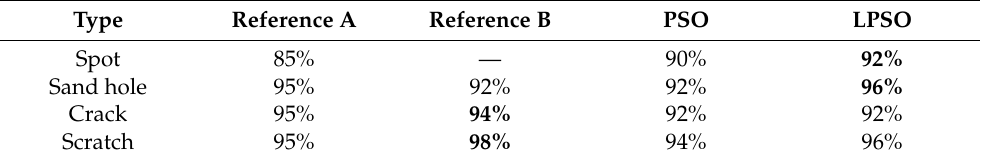
Table 7. The accuracy of other methods in the literature compared with the method used in this paper.